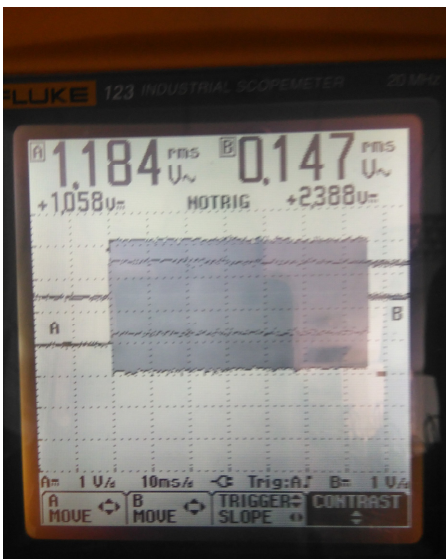
Figure 5. Illustration of the toggling pattern. The threshold value is set in software to 2.5 V; thus, when the voltage drops below (here captured at 2.388 V), the state and data of the microcontroller is saved. This is followed by the toggling pattern that indicates the end of the CTPL function (the ctpl_enterShutdown () function continues to toggle the pin while waiting for the device to enter a BOR).